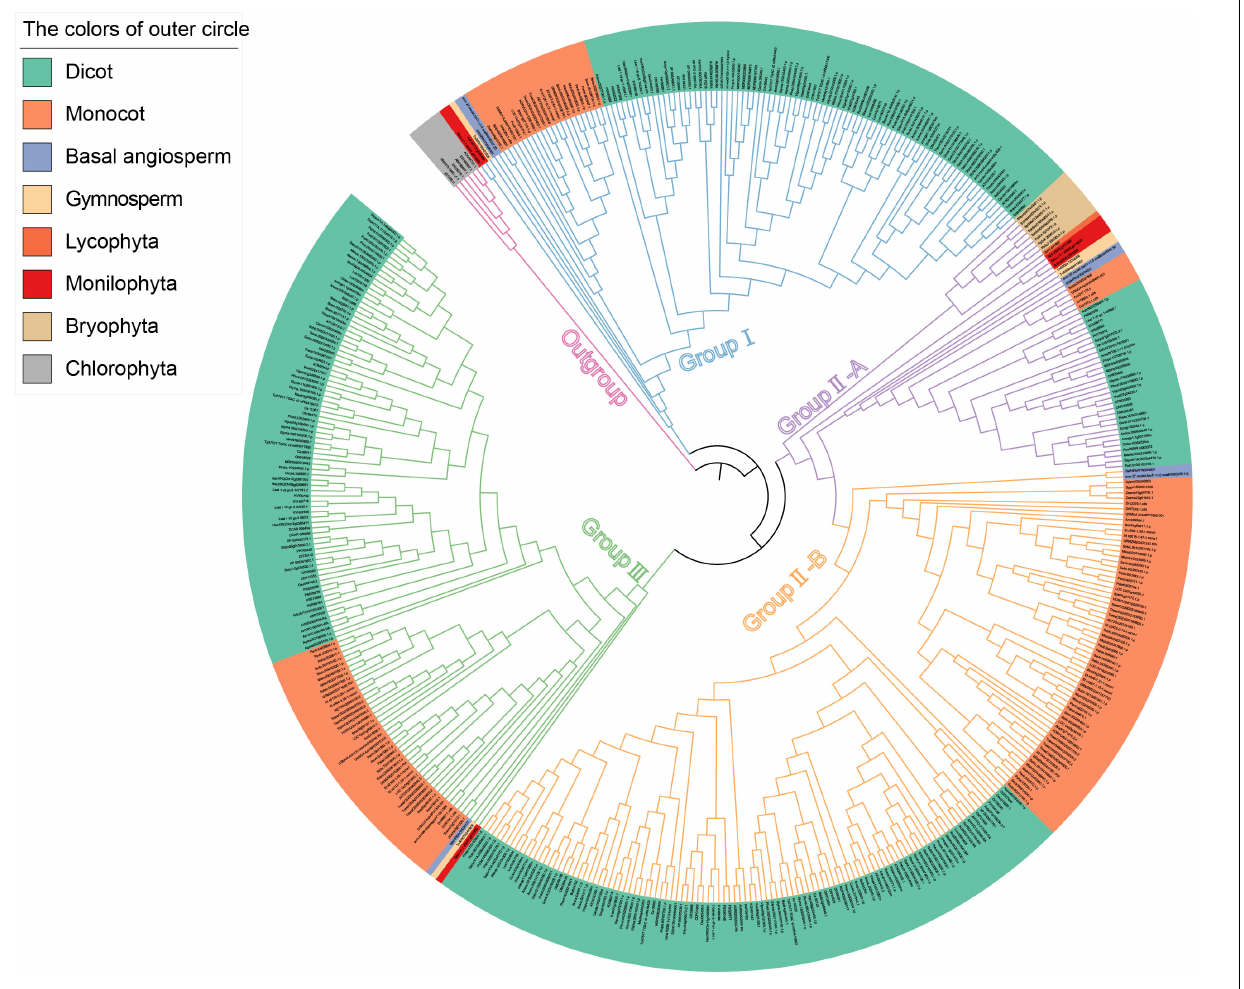
FIGURE 2 | Phylogenetic tree based on the identified CAMTAs. The different colors of the clades represent different groups. The background colors of the outer circle represent different